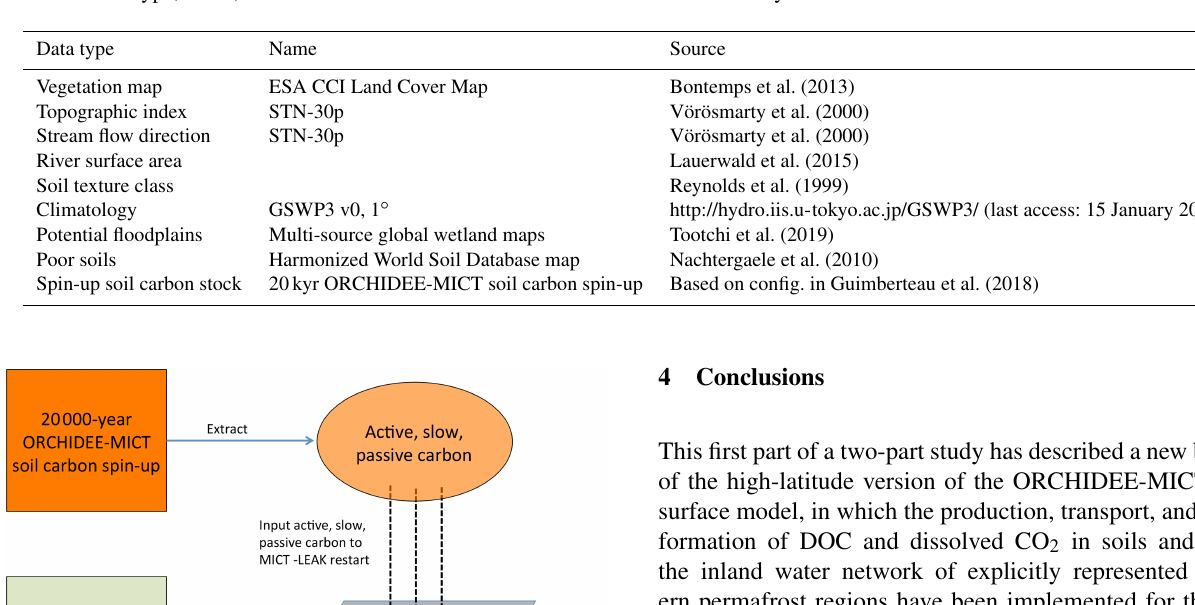
Table 1. Data type, name, and sources of data files used to drive the model in the study simulations.